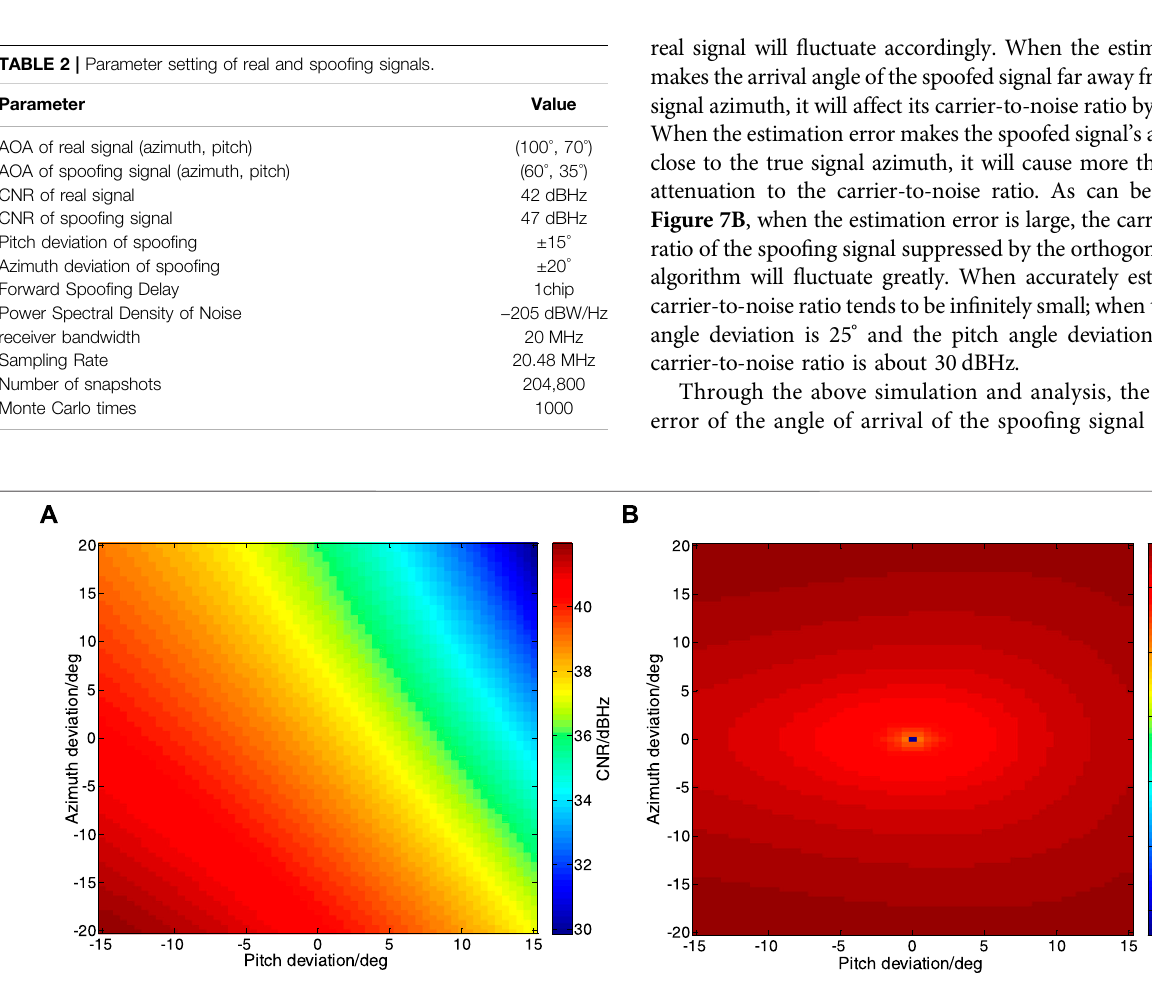
Frontiers in Physics |